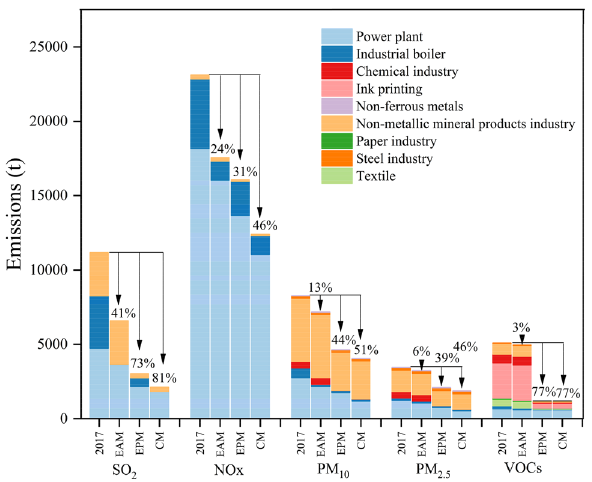
Figure 6. Sectoral emissions of major air pollutants from 11 parks in 2017 and three